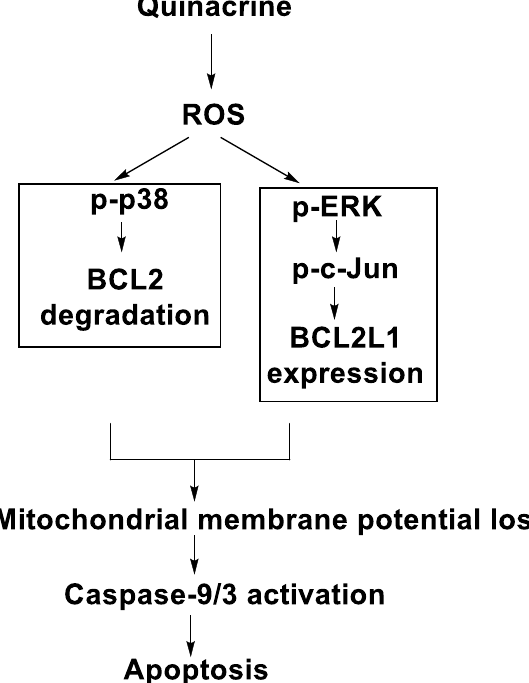
Figure 11. Signalling pathway responsible for the qunacrine-induced apoptotic death of K562